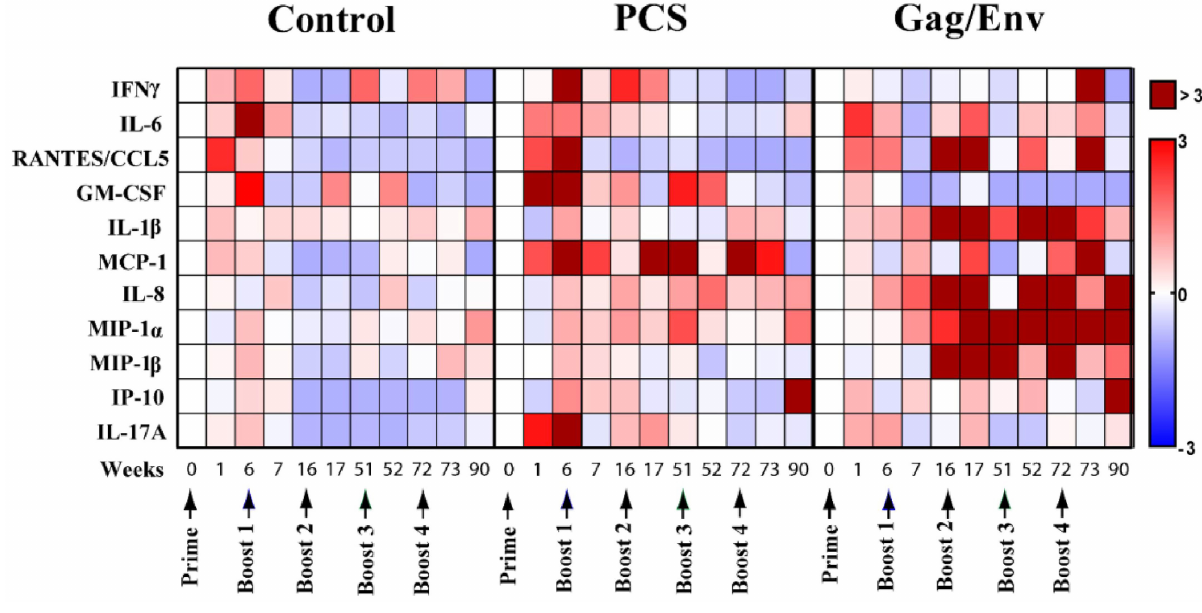
FIGURE 2 | Median cytokine/chemokine fold-change levels at each time point relative to group baseline (Week 0) in all 3 vaccine groups. The fold change was calculated as the ratio of the concentration to the baseline where baseline was set to 0. Arrows indicate each immunization. Bar = Fold change, Shades of blue = downregulated, Shades of red = upregulated. n = 8 monkeys/group ( n = 7 for Gag/Env). Experiments were run in